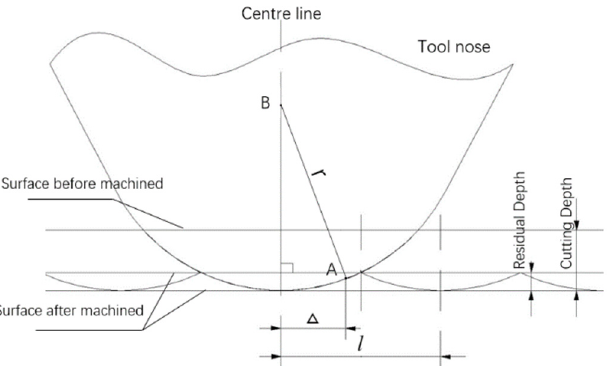
Figure 7. The surface topography geometrical model in SPDT(Pre). l is the length of feed per turn of workpiece; r is the arc tip radius; point A ( x A , y A , z A ) is an arbitrary position on the end surface of the workpiece; B ( x B , y B , z B ) is the center of the tool nose arc; ∆ is the distance between the center line of the tool nose and point A